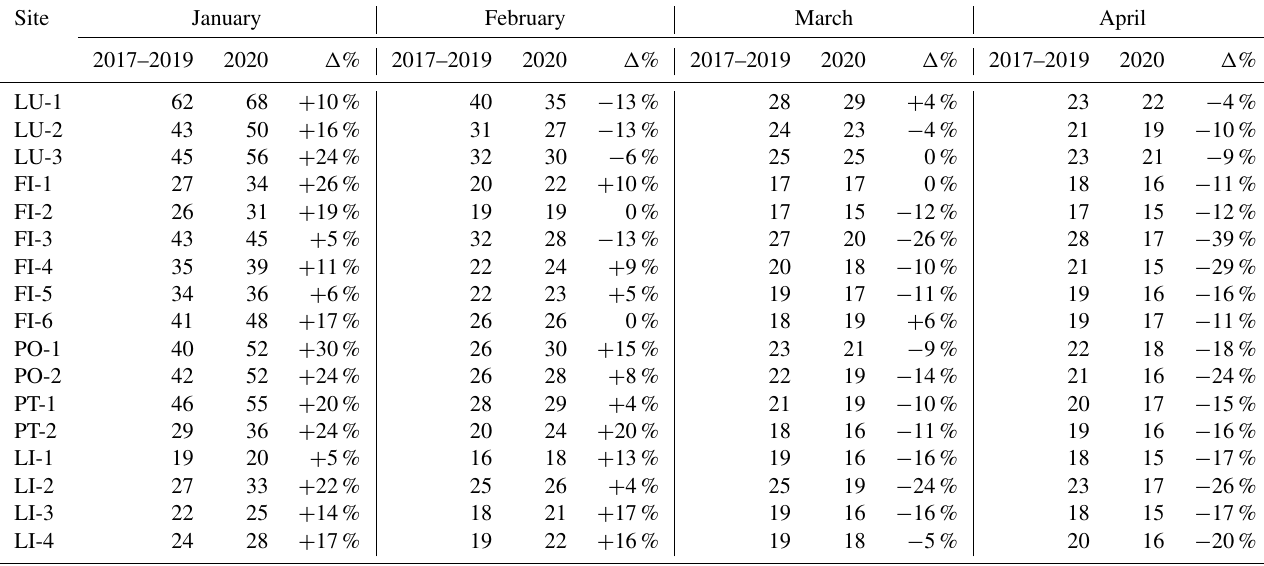
Table 3. PM 10 monthly mean concentrations (µgm − 3 ) for 2017–2019 and 2020 as well as the percentage variation ( (cid:49)